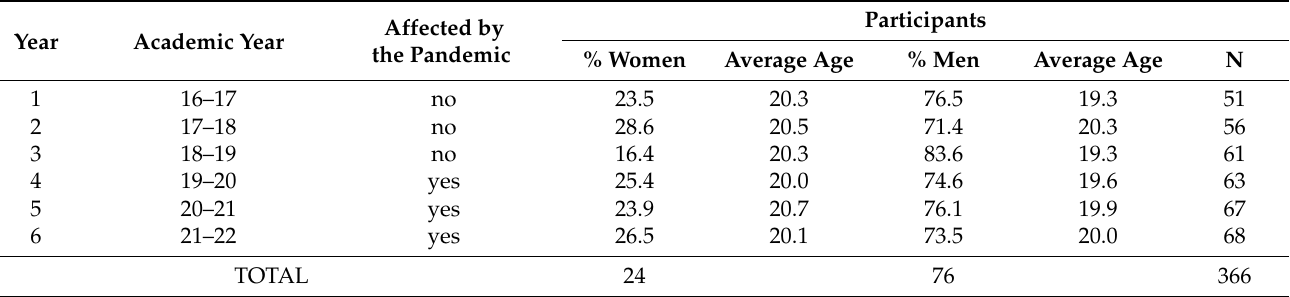
Table 1. Students participating in the